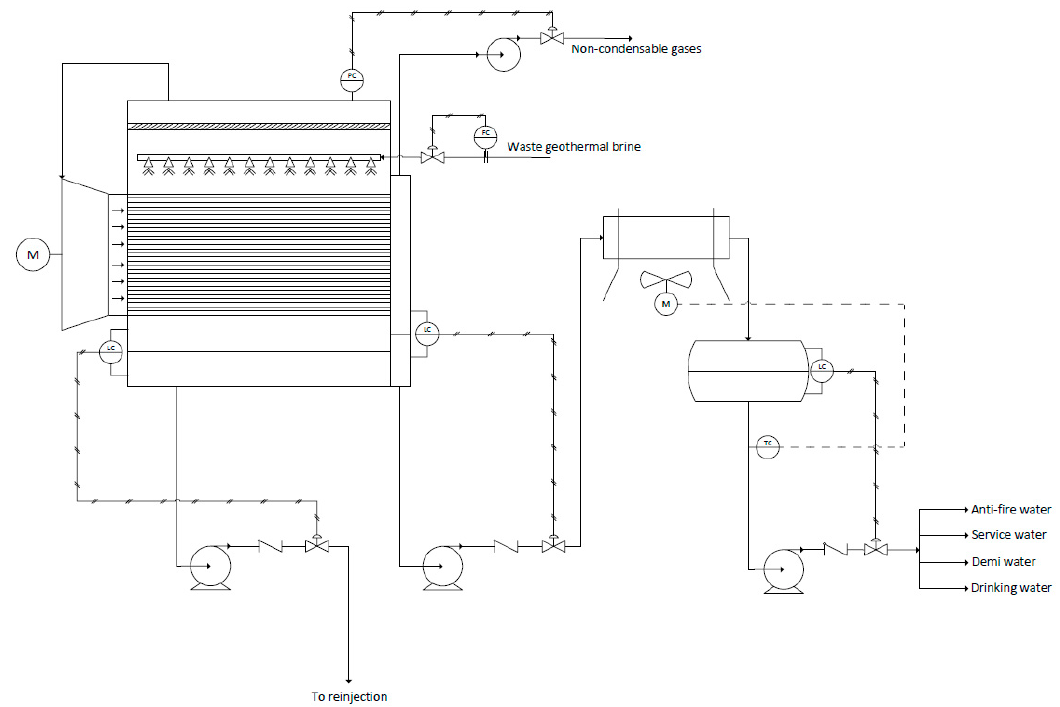
Figure 10. Simplified process scheme of the MVC desalination process under evaluation.